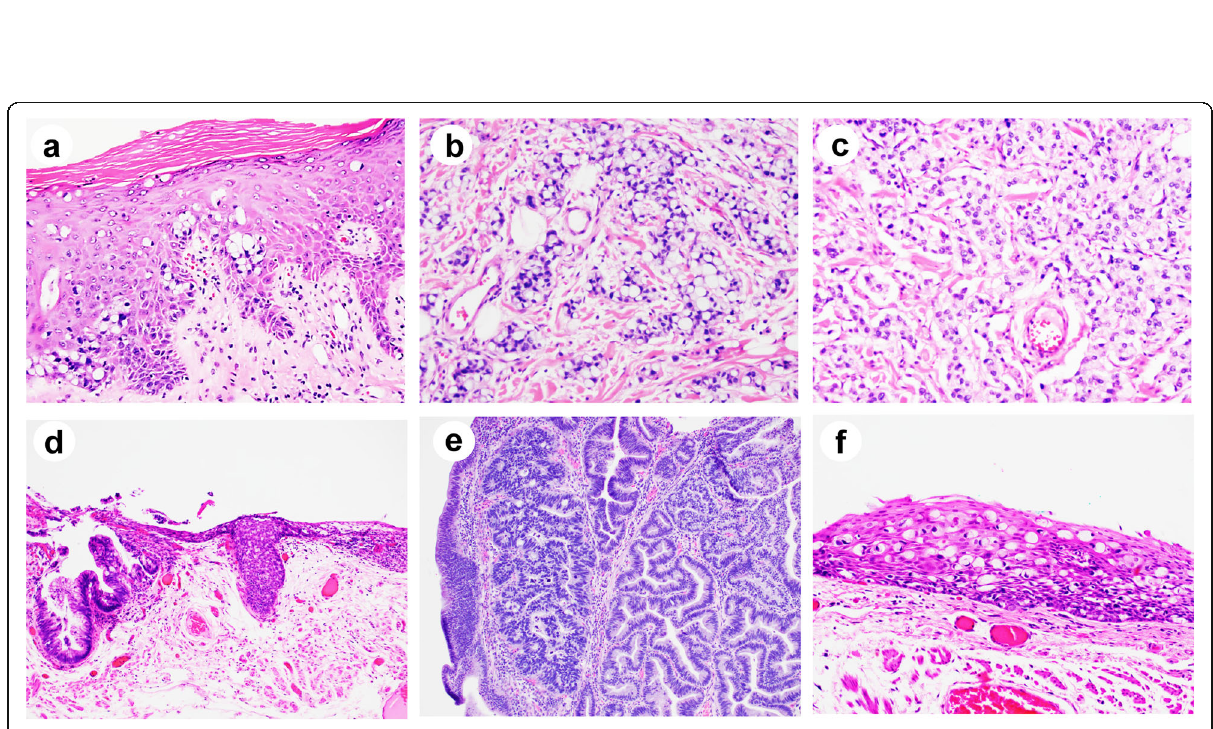
Fig. 2 Histologic features of secondary perianal Paget ’ s disease cases associated with underlying malignancy (hematoxylin and eosin). a-c High magnification (× 200) showed intraepithelial Paget ’ s cells ( a ) and underlying invasive adenocarcinoma with signet ring cell feature ( b ) and neuroendocrine feature ( c ). d Low magnification (× 100) showed intraepithelial Paget ’ s cells associated with a tubular adenoma with high-grade dysplasia. Higher magnification views (× 200) of (d) showed tubular adenoma with high-grade dysplasia ( e ) and Paget ’ s cells ( f